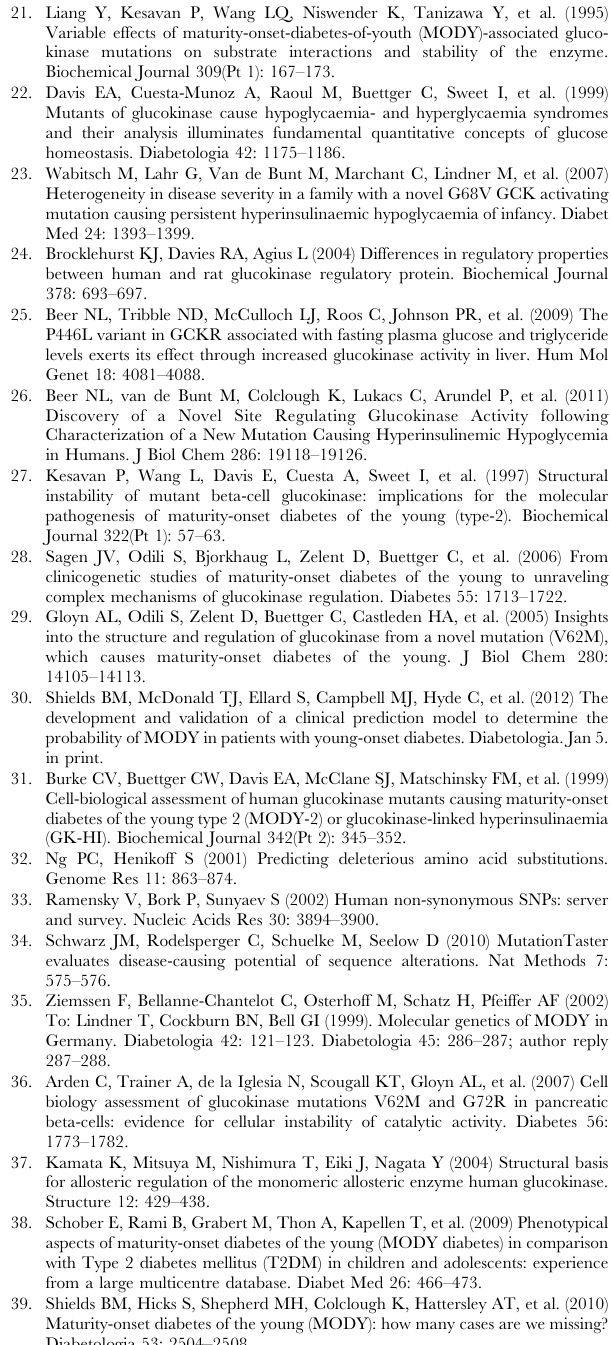
Table S1 In silico analysis of all missense mutations found in Slovakian